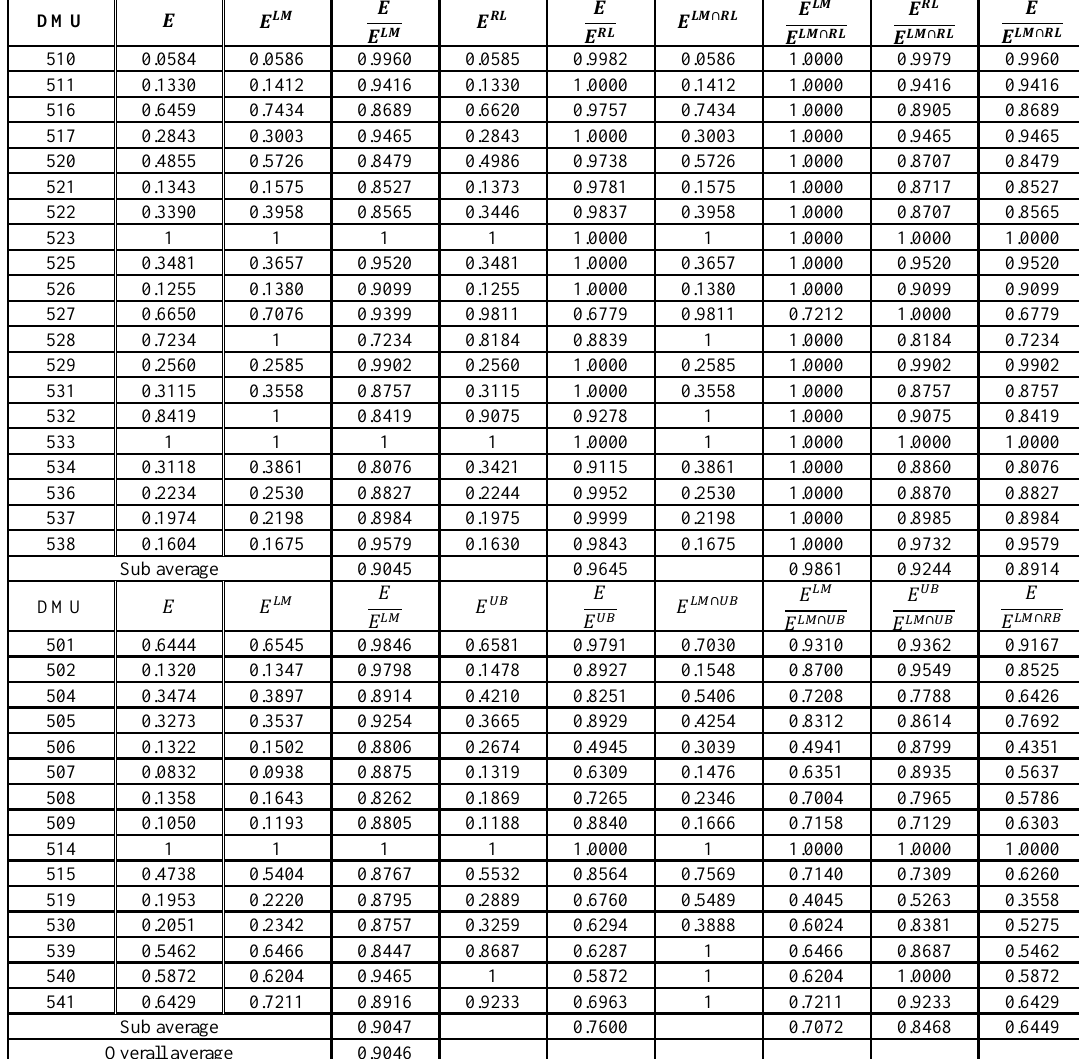
Table 3. Efficiencies of colleges of LNM